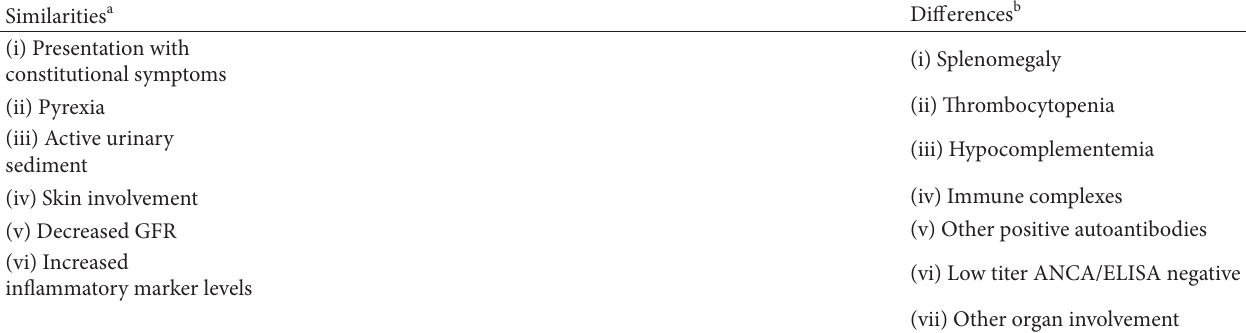
Table 2: Diagnostic aids for differentiating between infectious endocarditis and small-vessel vasculitis ∗ .